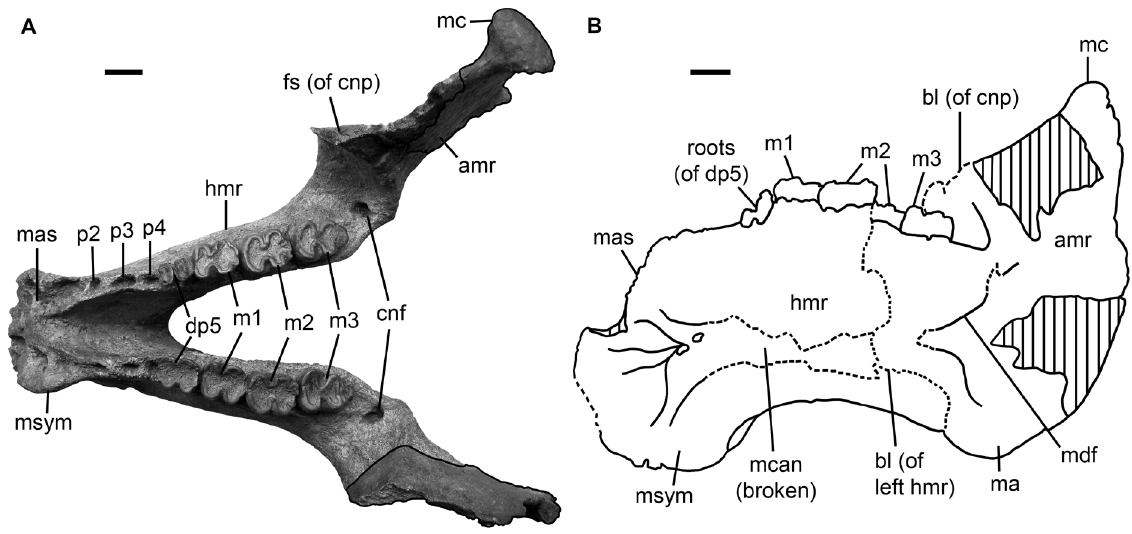
Fig. 6. Mandibles of Lentiarenium cristolii ( Fitzinger, 1842). A . Photograph of OLL 1939/257 (holotype of “Halitherium” abeli (Spillmann, 1959)) in occlusal view. B . Outline drawing of OLL 2012/1 (lectotype) in left lateral view revealing information on the medial side of the right mandible. Dashed lines indicate broken parts. Both outlined (A) and shaded (B) areas indicate either missing or reconstructed parts. Scale bars = 2